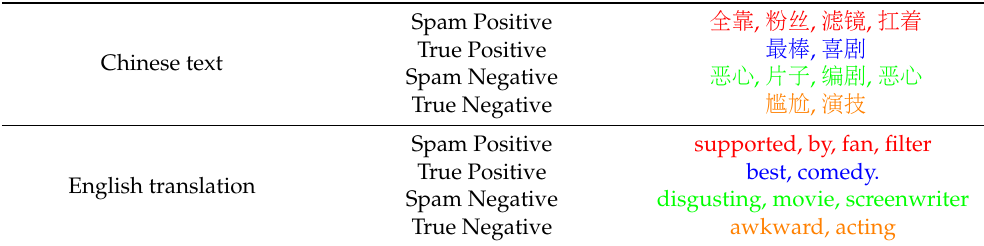
Table 13. Segments of Samples.